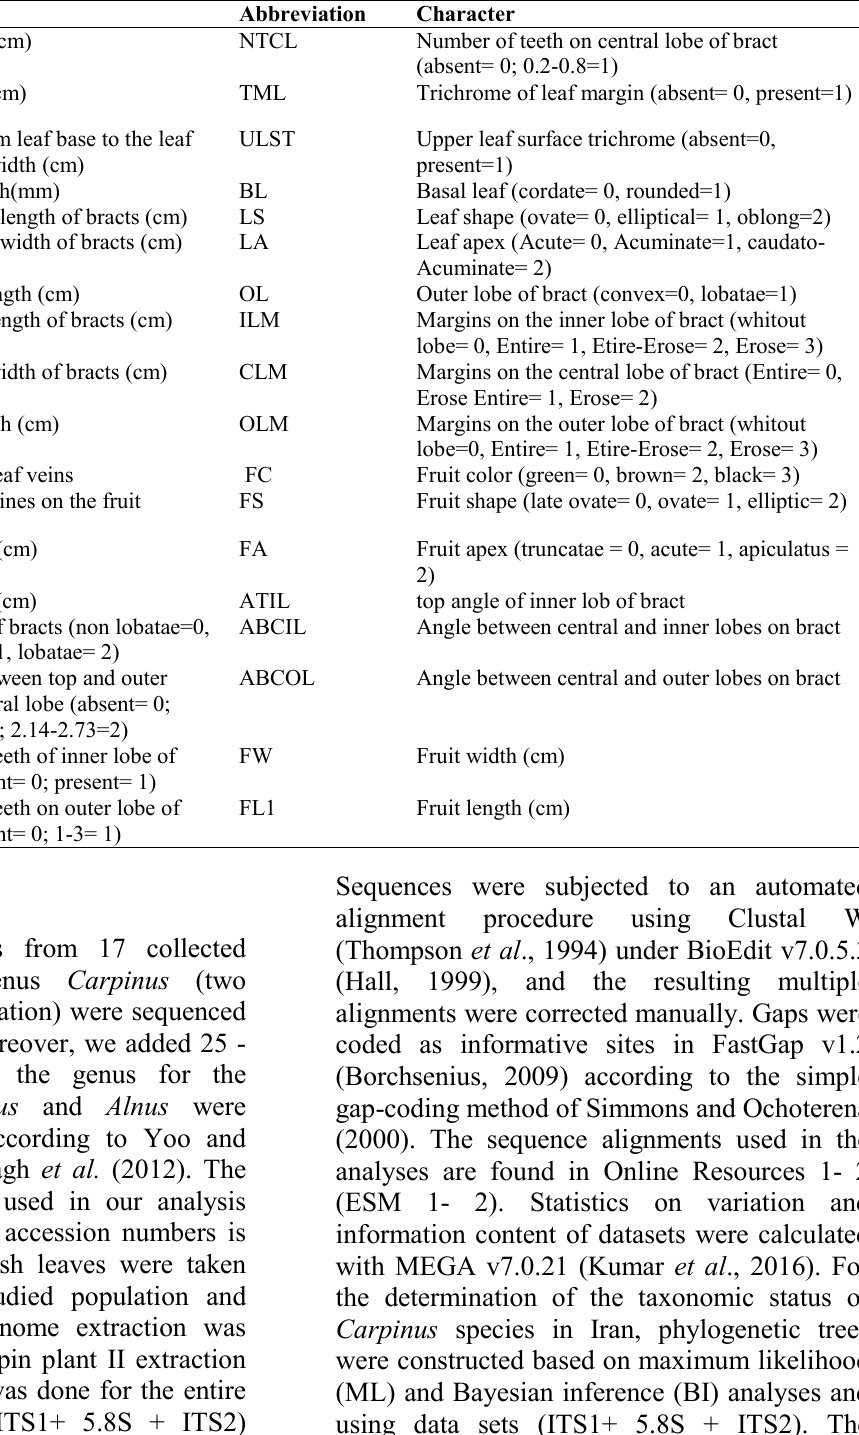
Table 3. Quantitative and Qualitative characteristics of the studied materials of